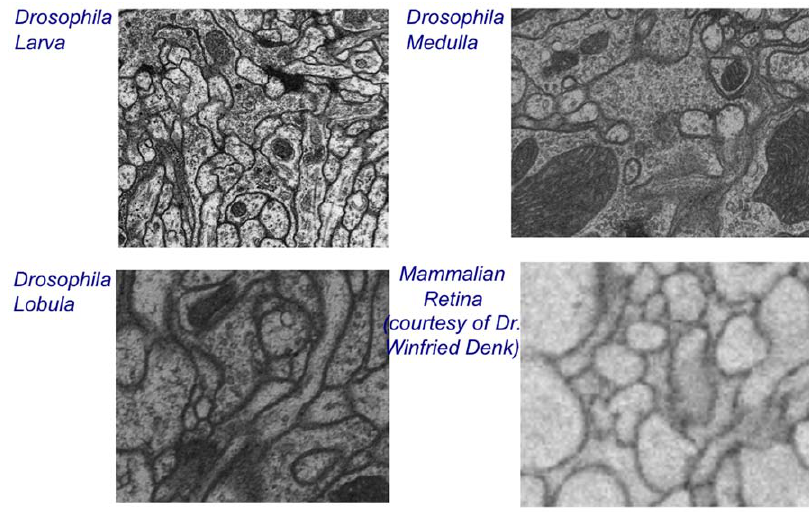
Figure 5. EM data samples used in the experiments.